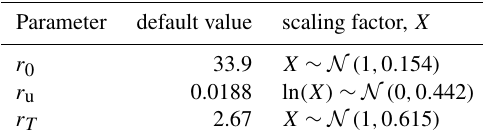
Table 5. Carbon cycle parameter